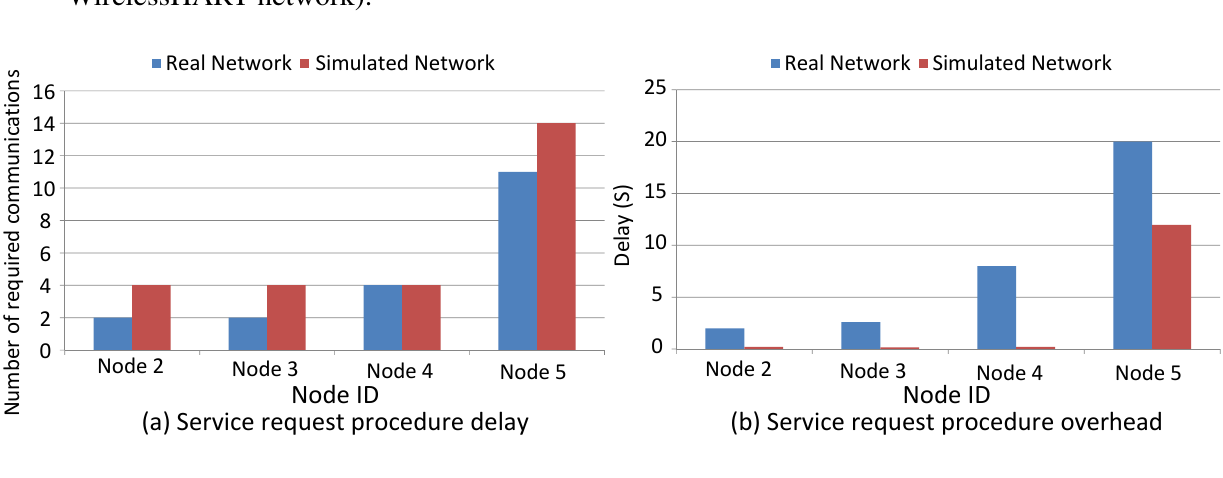
Service request procedure ( a ) overhead and ( b ) delay (real vs . simulated WirelessHART